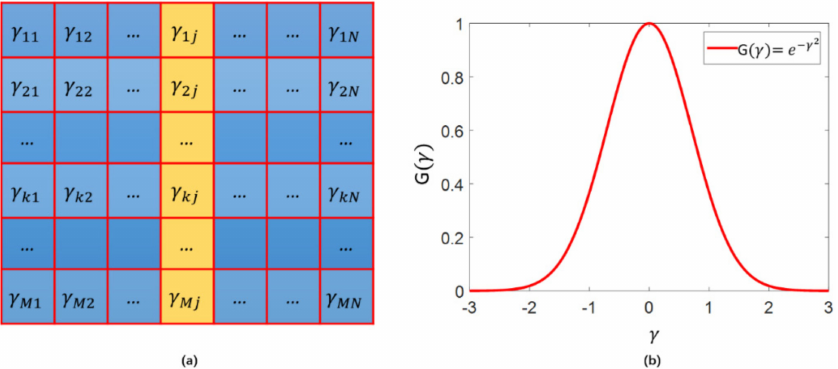
Figure 2. The curve of the gate function and its independent variables: ( a ) independent variables of the gate function; ( b ) curve of the gate